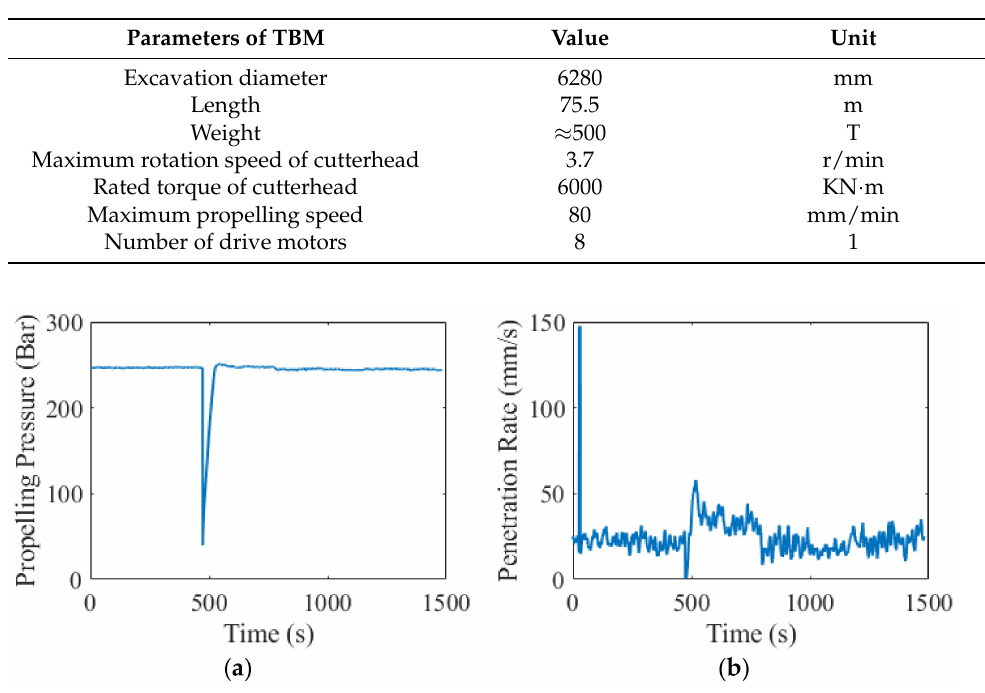
Figure 4. The earth pressure balance shield TBM used. Table 1. Basic parameters of the TBM used.